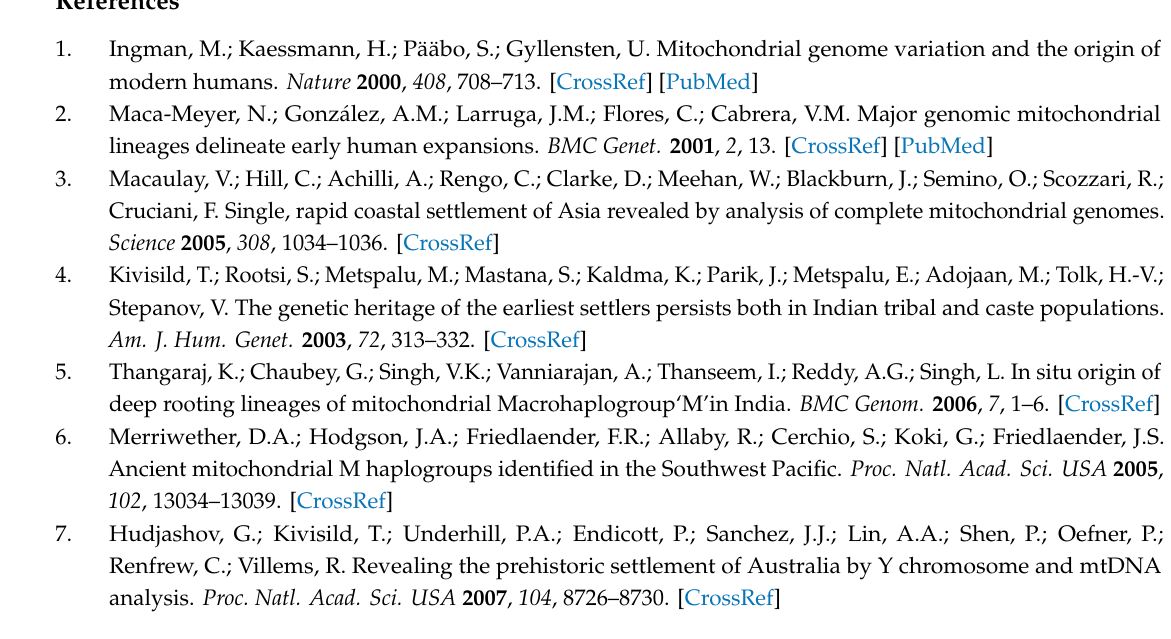
Table S1. The haplogroups / sub-haplogroups distribution per city in the UAE population. Table S2. Pairwise Fst among the di ff erent cities of the UAE population. Table S3. Summary statistics of Hs and Ht for di ff erent cities of the UAE population. Table S4. Summary of the statistic of Gst, Htmax, Gstmax, and G’st. Table S5. Summary of filtered heteroplasmy counts and disease associated annotation. Figure S1. Venn diagram of the di ff erent sub-haplogroups among cities of the UAE. Figure S2. Prediction of the MFE structure tRNAHis gene in wild type and mutant (A12172G). Supplementary data zipped. Zipped plots from eKLPse software for the 232 individuals long structural